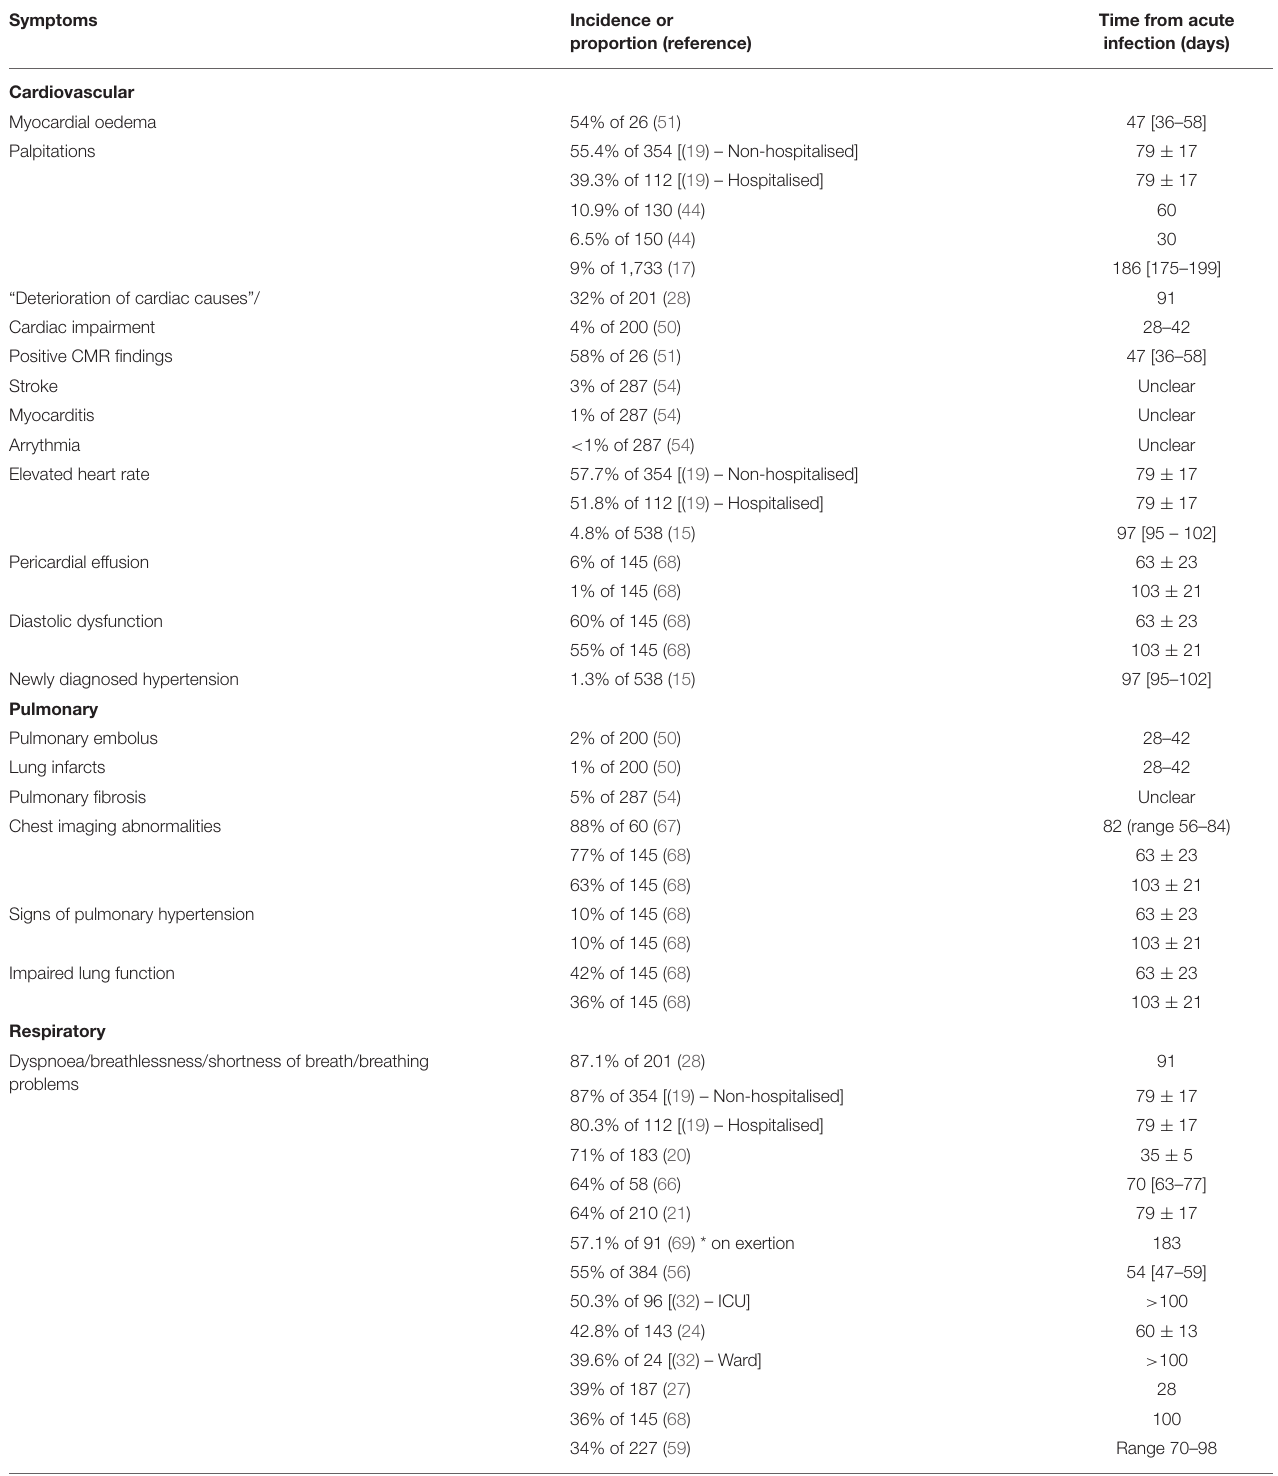
TABLE 2 | Summary of long COVID symptoms, grouped by category, with prevalence reported in each study and studies listed in order of prevalence for each symptom.